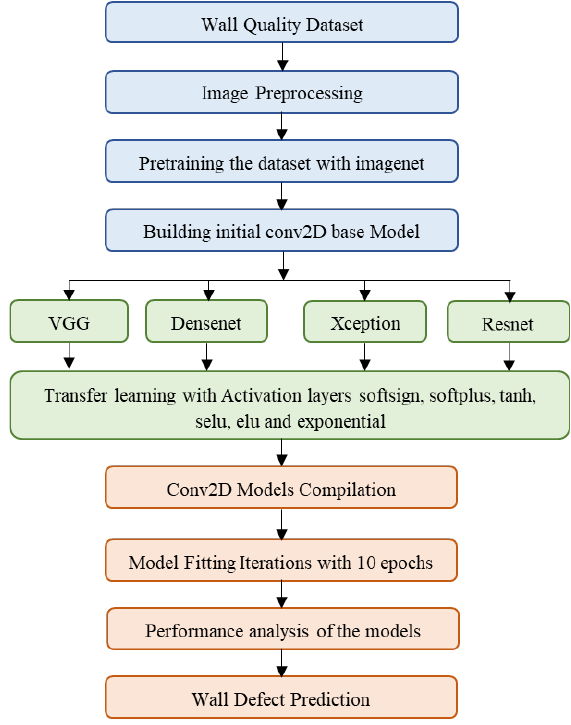
Figure 3. Workflow of Conv2D ResNet exponential model.